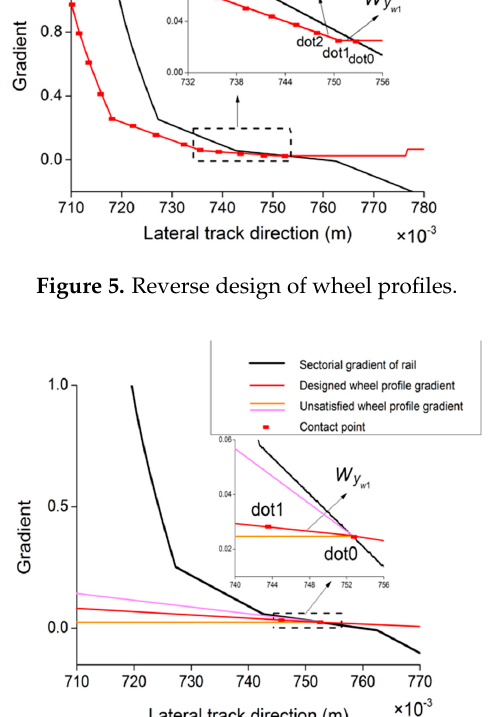
Figure 6. Reverse design of wheel profile section W y